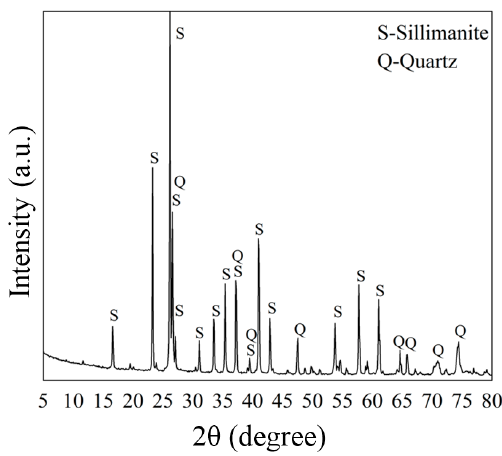
Figure 2. X-ray diffractometer (XRD) spectra of the sillimanite sample. Table 1. The chemical composition of the sillimanite sample.